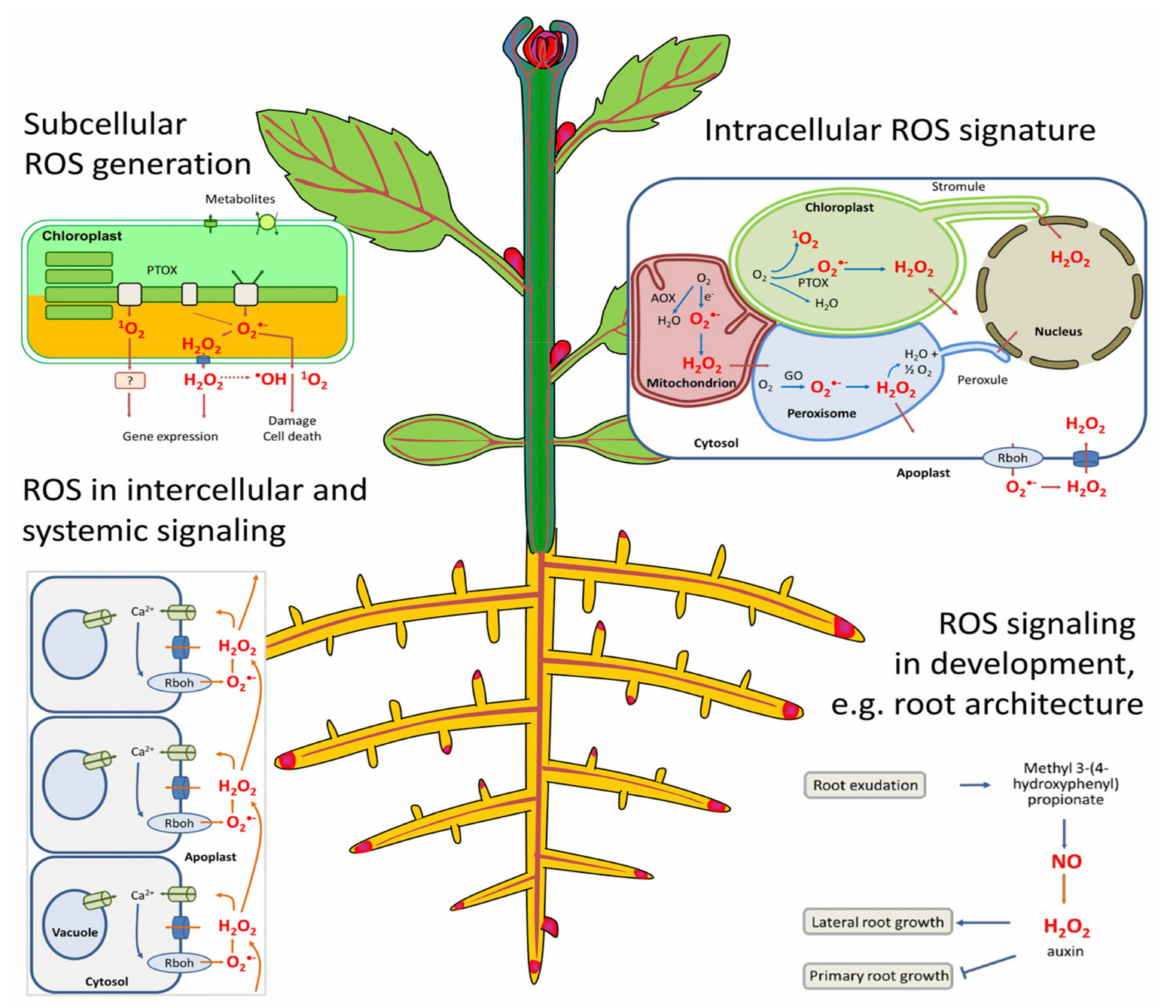
Figure 1. Roles of reactive oxygen species (ROS) involving multiple regulations in different cellular compartments of a plant